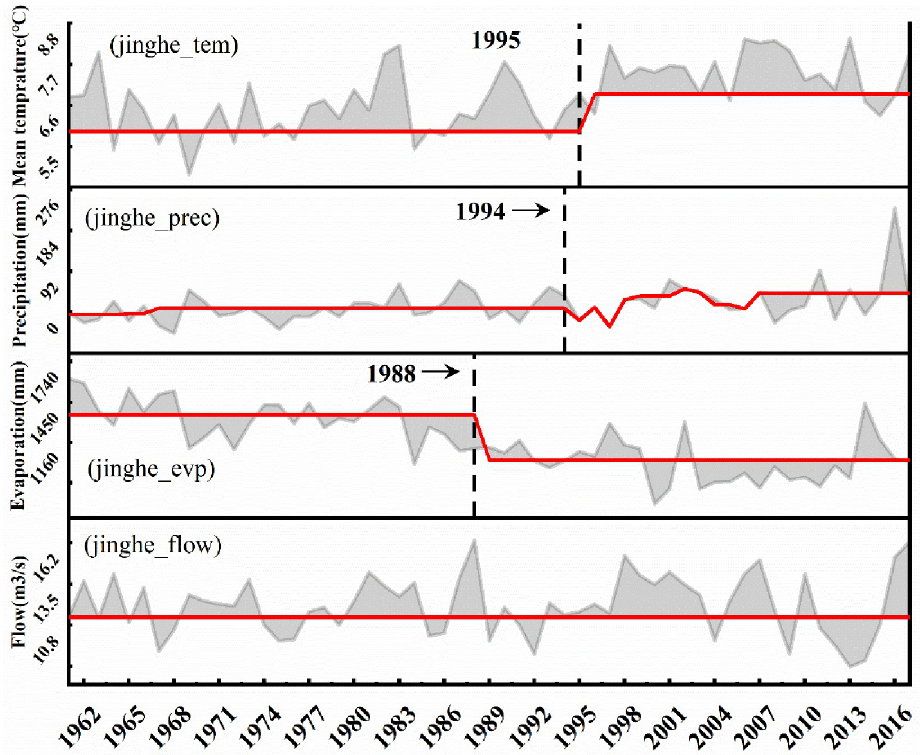
Fig 5. Temporal changes of hydroclimatic variables at Jinghe station ( p < 0.05). The gray line, red line, and gray area represent the runoff observation, breakpoint segmentation value, and coverage area,